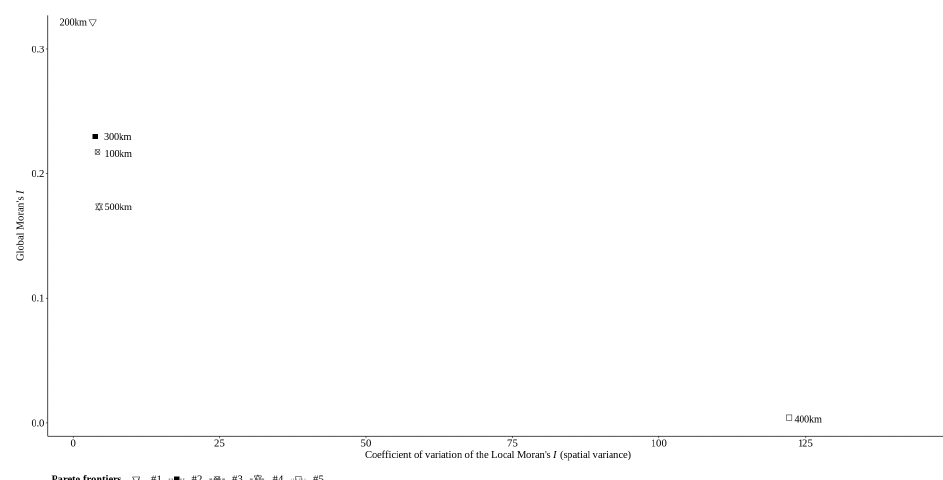
Figure 5. Pareto frontier and trade-off between Global Moran’s I and the coefficient of variation of Local Moran’s I .